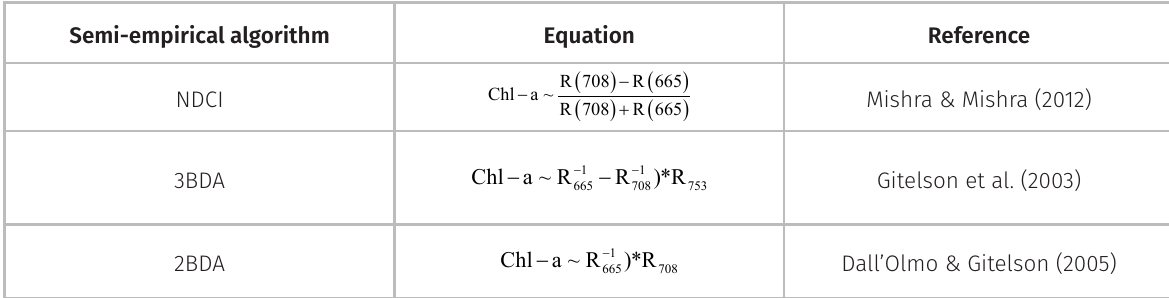
Table I. Semi-empirical algorithms to estimate Chl- a concentration. Semi-empirical